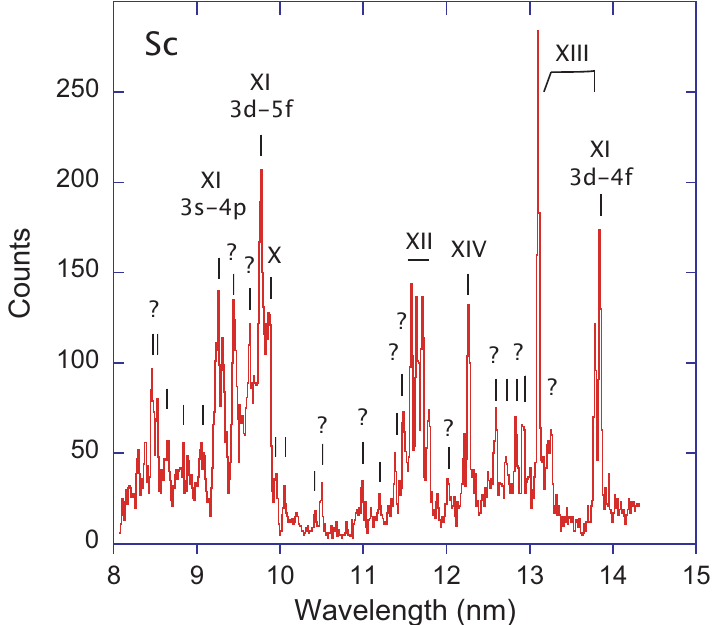
Figure 5. Beam-foil spectra of Sc at an ion beam energy of 23MeV. Observation at the foil. Line width (FWHM) 0.03nm. The strongest lines are identified by the spectrum number. The wavelength coverage of this spectrum extends the spectrum in